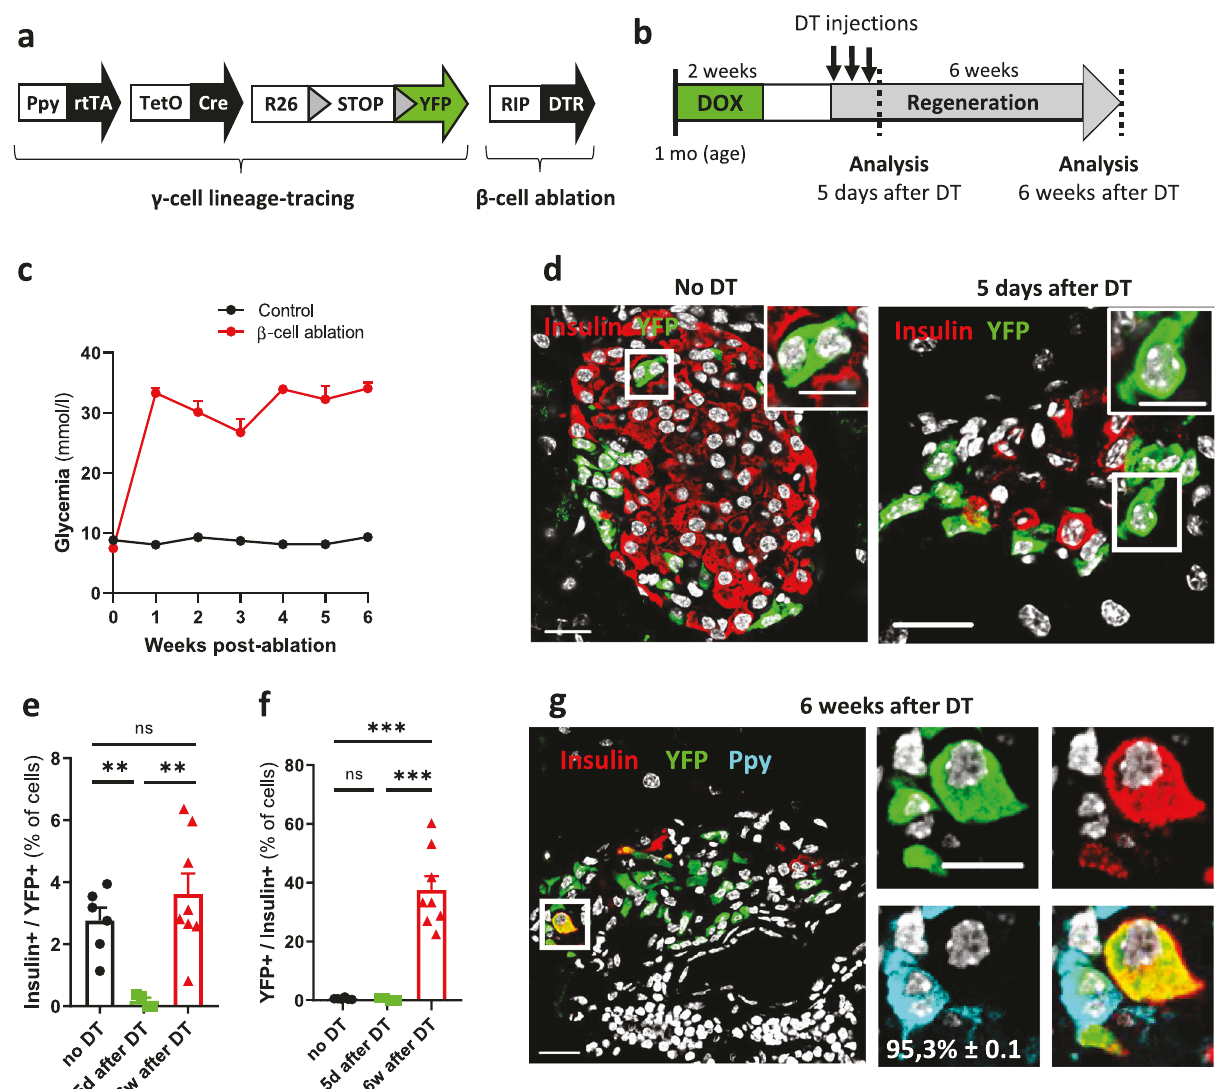
Fig. 8 Murine γ -cells engage insulin production after massive β -cell loss. a Transgenes required for tracing γ -cells in combination with β -cell ablation. b Experimental design. c β -cell ablated mice ( n = 7 mice) become severely diabetic one week after β -cell death compared to control mice ( n = 6 mice). Insulin implants were administrated one week after DT-mediated β -cell death. d Adult YFP-labeled cells can engage insulin expression after diphtheria toxin (DT)-mediated β -cell loss. Immuno fl uorescence of insulin (red) and YFP (green) in control ( “ No DT ” ) and 5 days or 6 weeks after DT injection. Almost no YFP-labeled cells contained insulin 5 days after DT (0.1%; n = 4 mice). Scale bars: 20 μ m or 10 μ m (insets). e Proportion of YFP-labeled cells that start insulin production after β -cell ablation. Two-tailed Mann – Whitney test, no DT versus 5d after DT: P value = 0.0095; 5d after DT versus 6w